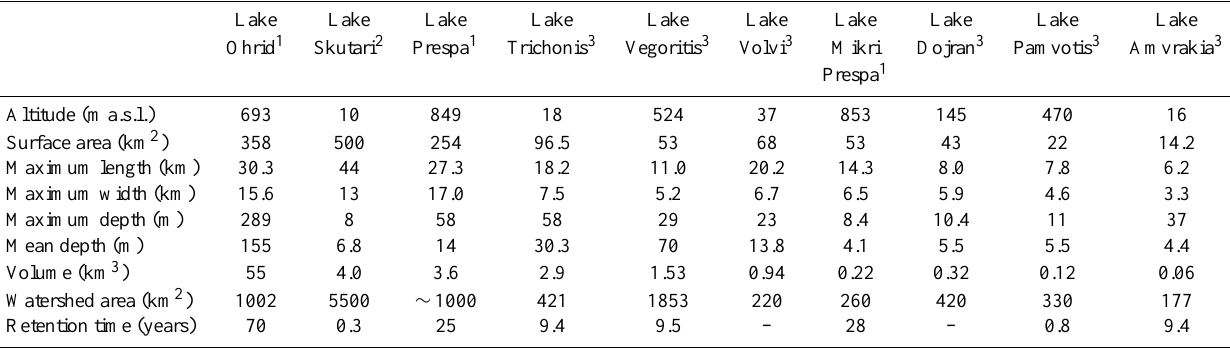
Table 2. Summarized physiographical and hydrological characteristics of large natural lakes in the southwestern Balkans from which specimens of Dreissena spp. were